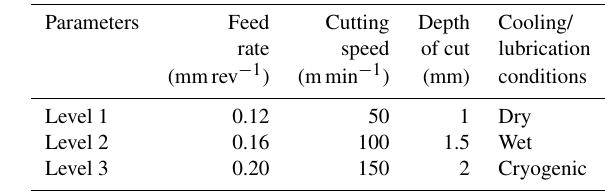
Table 3. Selected input machining parameters.